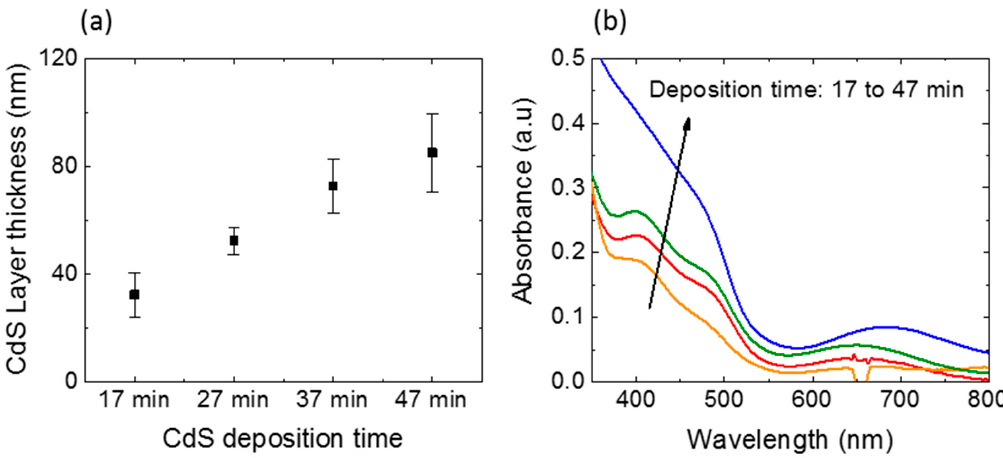
Figure 2. ( a ) Variation of CdS film thickness and ( b ) optical absorption spectra of CdS thin films fabricated with different deposition time.